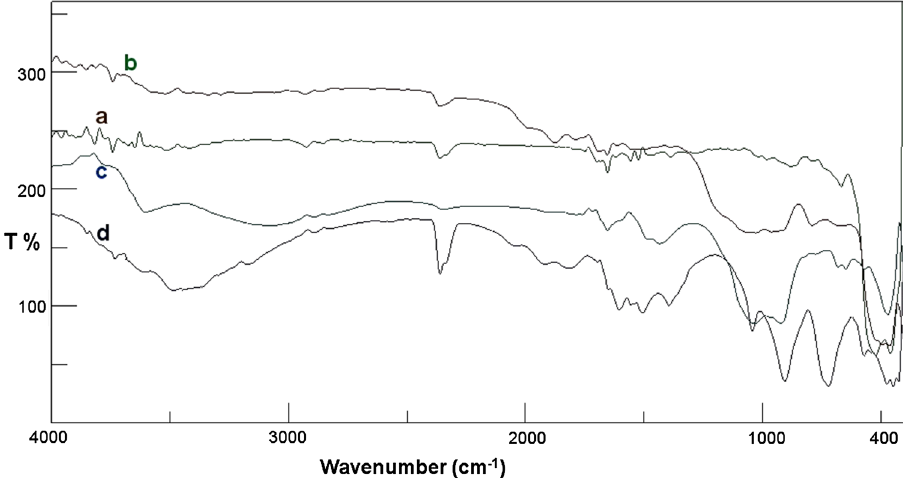
Fig. 6 FTIR spectra of a Pure ZnO nanoparticles; b Ag/ ZnO nanoparticles c Cd/ZnO nanoparticles; d Pb/ZnO nano-